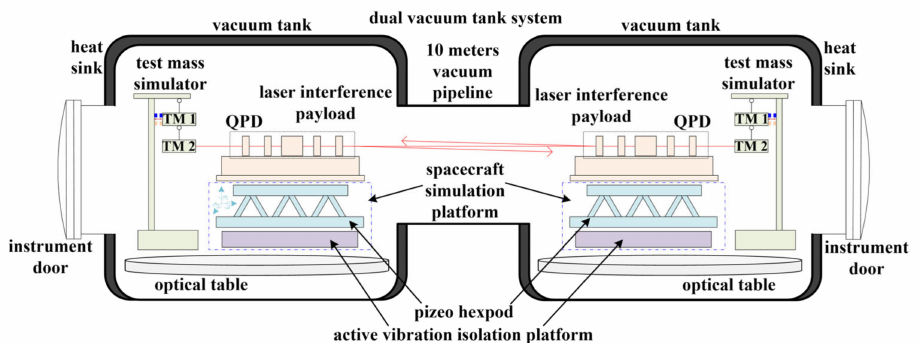
Figure 3. Schematic diagram of the experimental platform for semi-physical simulations test of inter-satellite laser interfer- ence (side view).